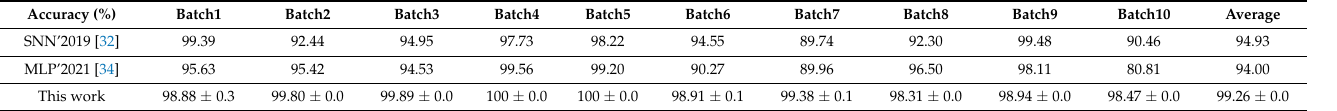
Table 4. The test accuracy comparisons of the publicly available UCSD gas sensor drift